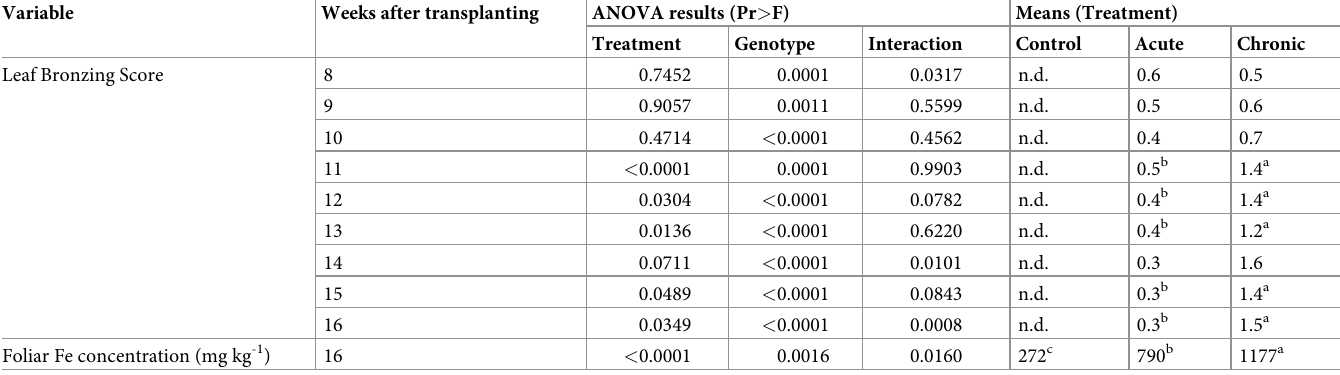
Table 1. ANOVA results and treatment mean values for traits determined during the vegetative growth of wild and domesticated rice species exposed to acute or chronic iron toxicity. Variable